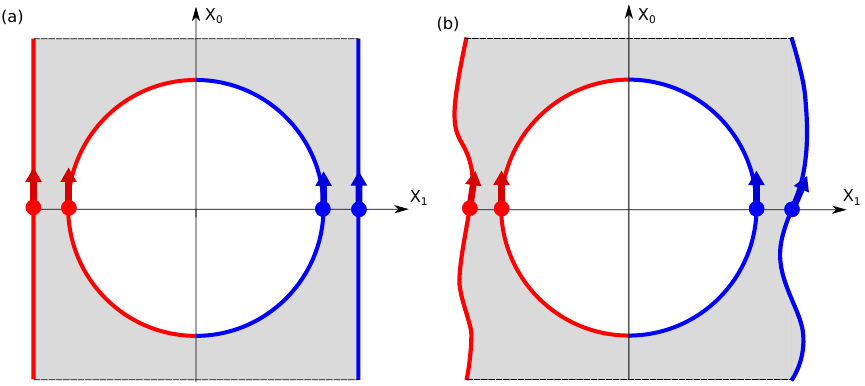
Figure 2 . Flat space instantons, describing the breaking of the string (cid:13)ux tube. The instanton on the left describes breaking of the (cid:13)ux tube where the external quarks are at a (cid:12)xed distance, while the instanton on the right depicts external quarks which \move" on arbitrary